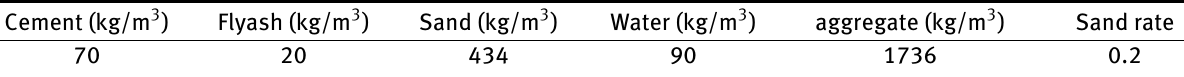
Table 3: Some project mix proportion